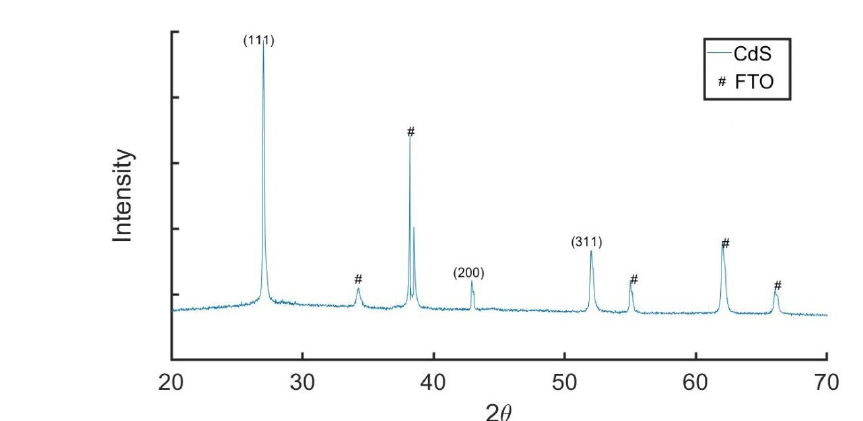
Figure 2. Difratogram of the CdS film on FTO substrate. Source the